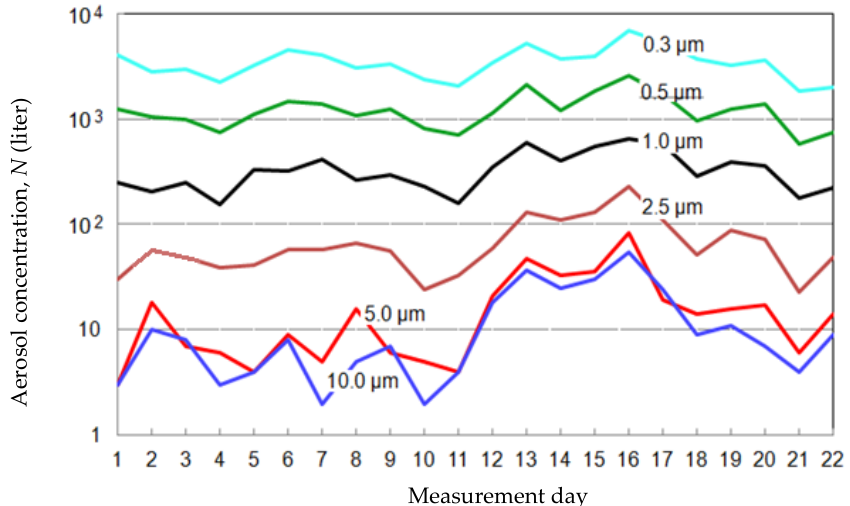
Figure 9. Concentration of natural aerosol over the site in the afternoon in the size ranges of 0.3, 0.5, 1.0, 2.5, 5, 10 µm.